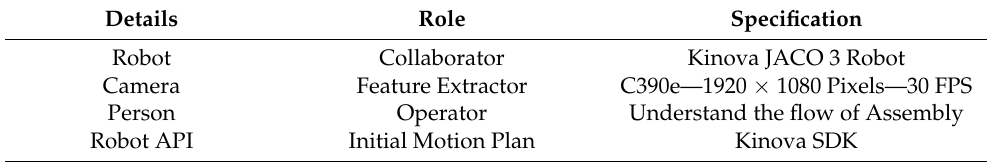
Table 6. Details of the experimental setup.